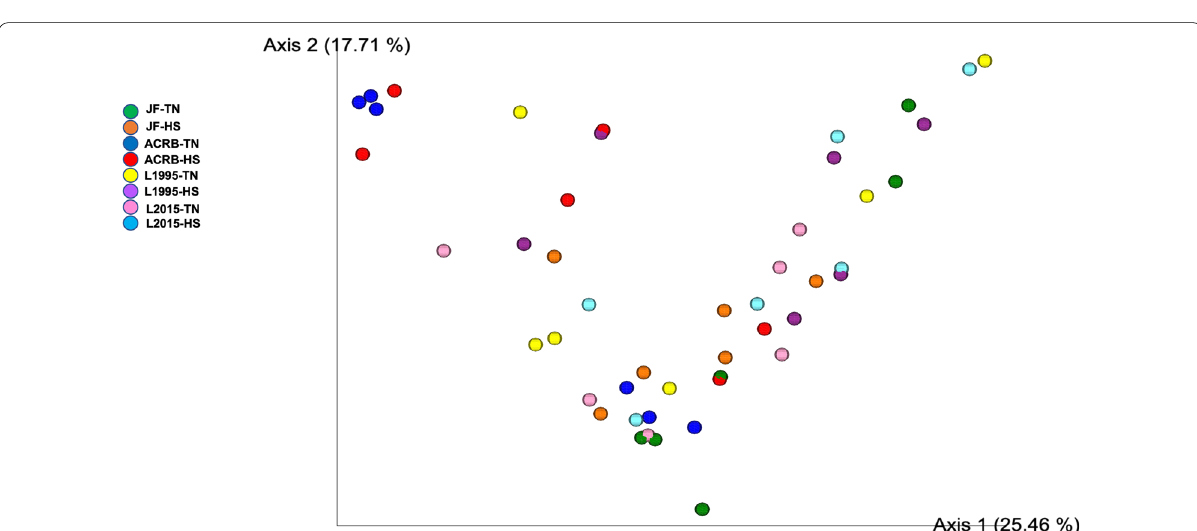
Fig. 2 Beta diversity in the ileal content of Jungle Fowl (JF), Athens Canadian Random Bred (ACRB), 1995 Random Bred (L1995), and 2015 Modern Random Bred (L2015) chicken lines raised under thermoneutral (TN) or heat stress (HS) condition (8 h/d; 36 °C) on d 56. 2D principal coordinate analysis (PCoA) plot is based on weighted UniFrac distance matrix. Each sphere represents a